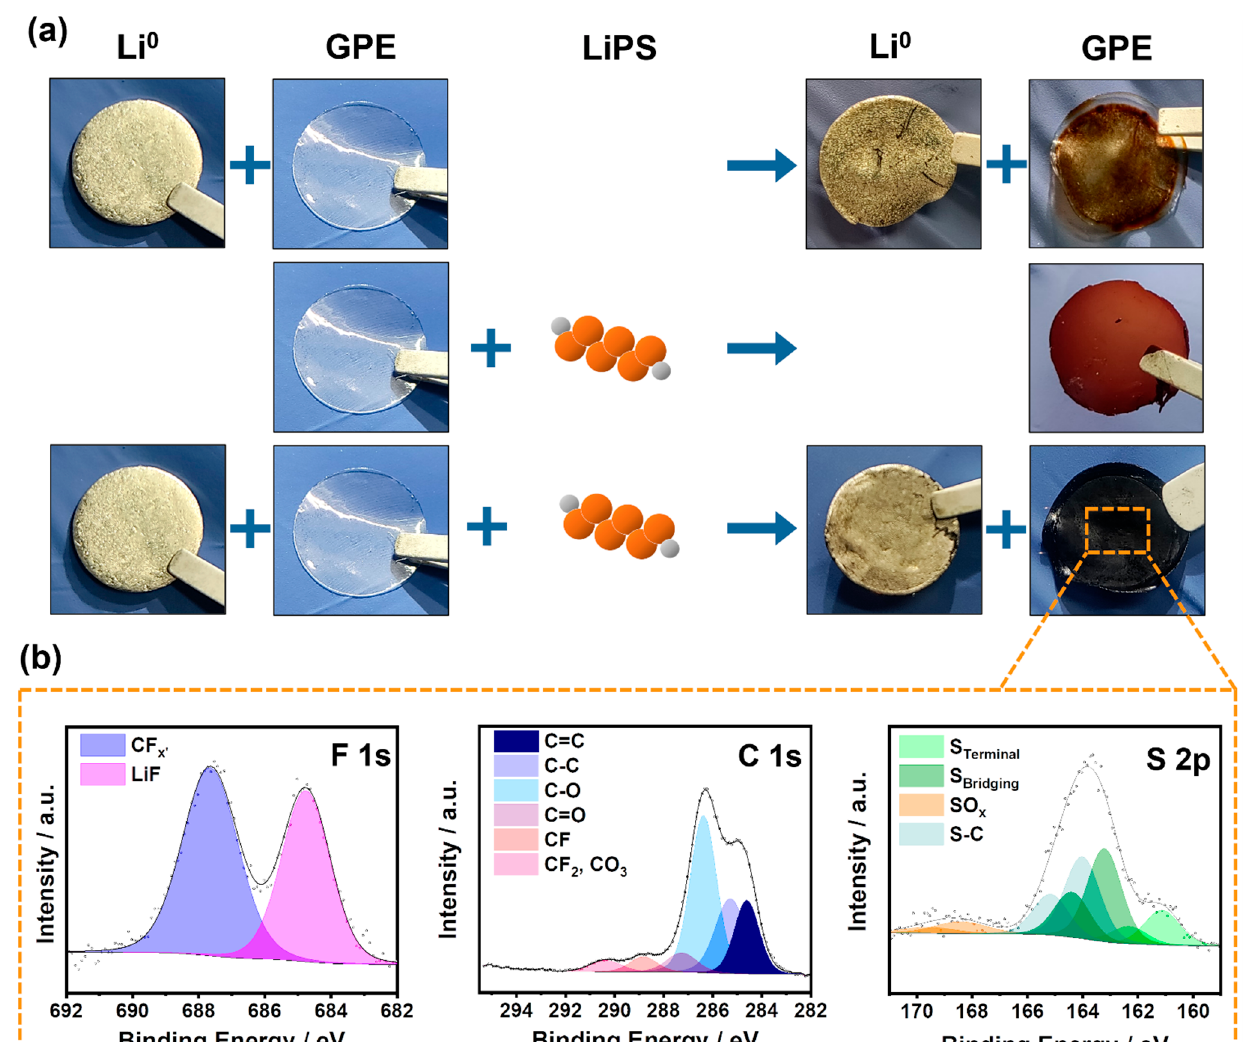
Figure 4. ( a ) Schematic illustration of the behavior of the membrane towards the different cell compounds. ( b ) XPS of F 1s, C 1s, and S 2p of the GPE after the combination of the dehydrofluorination process of the GPE and the presence of LiPS.